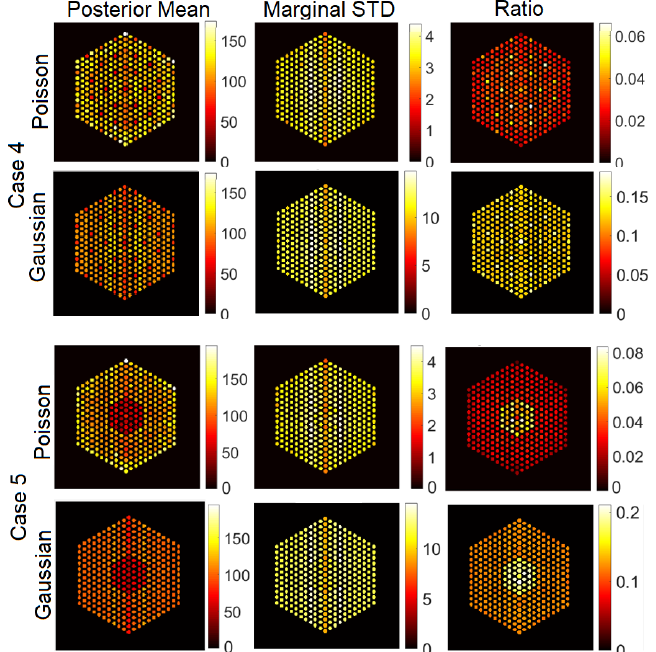
Figure 18. The FULL response matrix: pin pixels averaging of the proposed approach for Case “4” and Case “5”. ( Left-hand column ): posterior mean; ( middle column ): marginal standard deviation; and ( right-hand column ): the ratio of marginal standard deviation divided by posterior